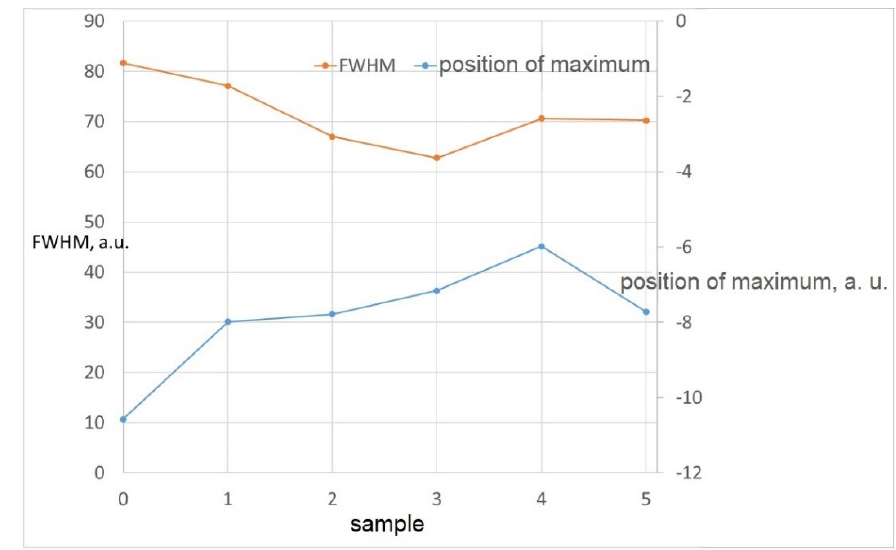
Figure 9. Dependence of rollers and MBN.